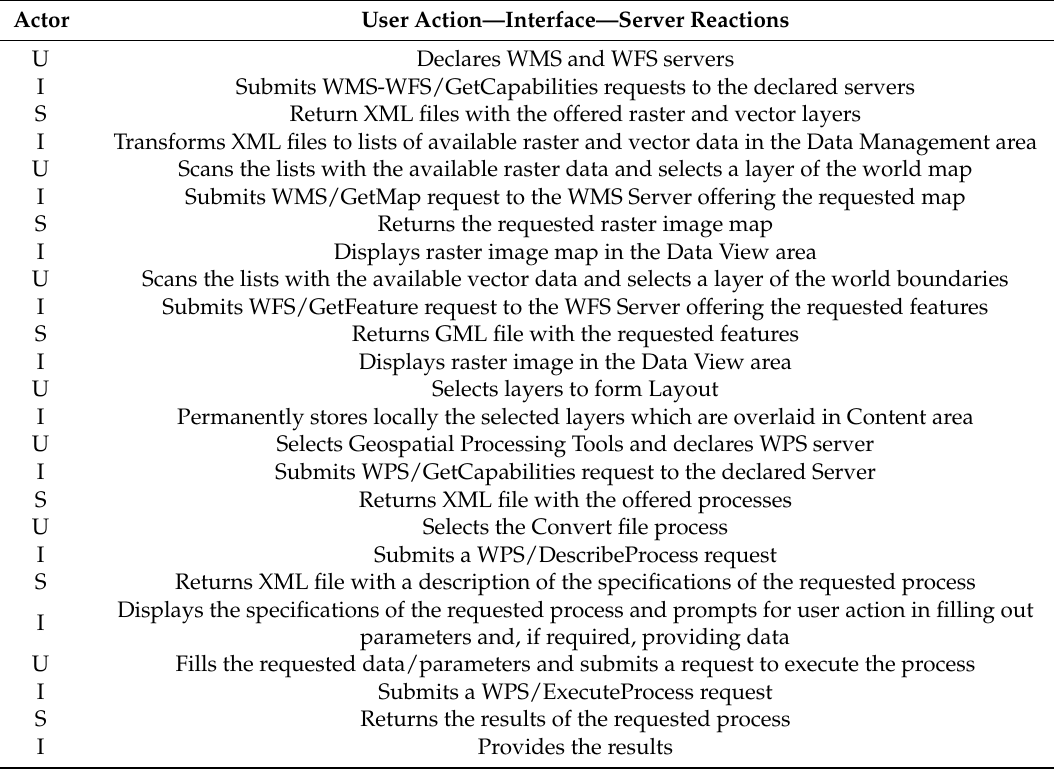
Table 2. User actions, interface handling and server reactions.